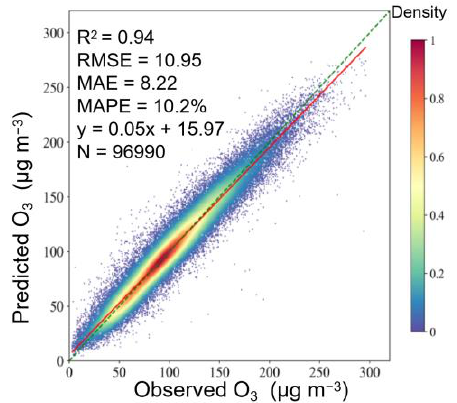
Figure 7. Scatter plot of the generated data and in situ observations.